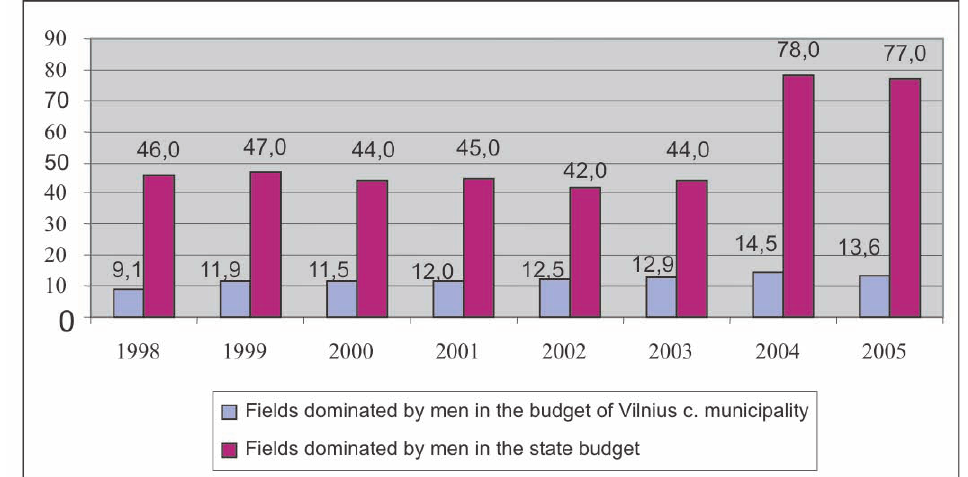
Fig 6. Allocations to the “male” sectors from municipality and state budgets, 1998–2005,